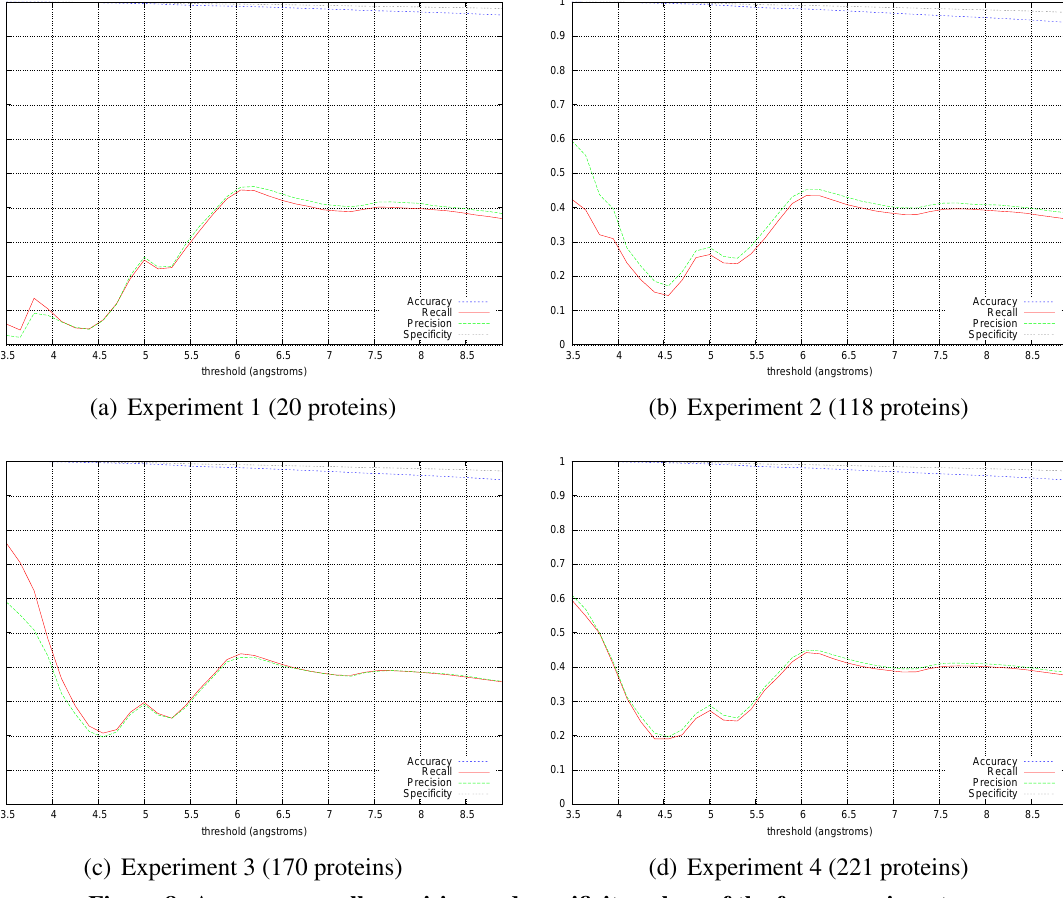
Figure 8: Accuracy, recall, precision and specificity values of the four